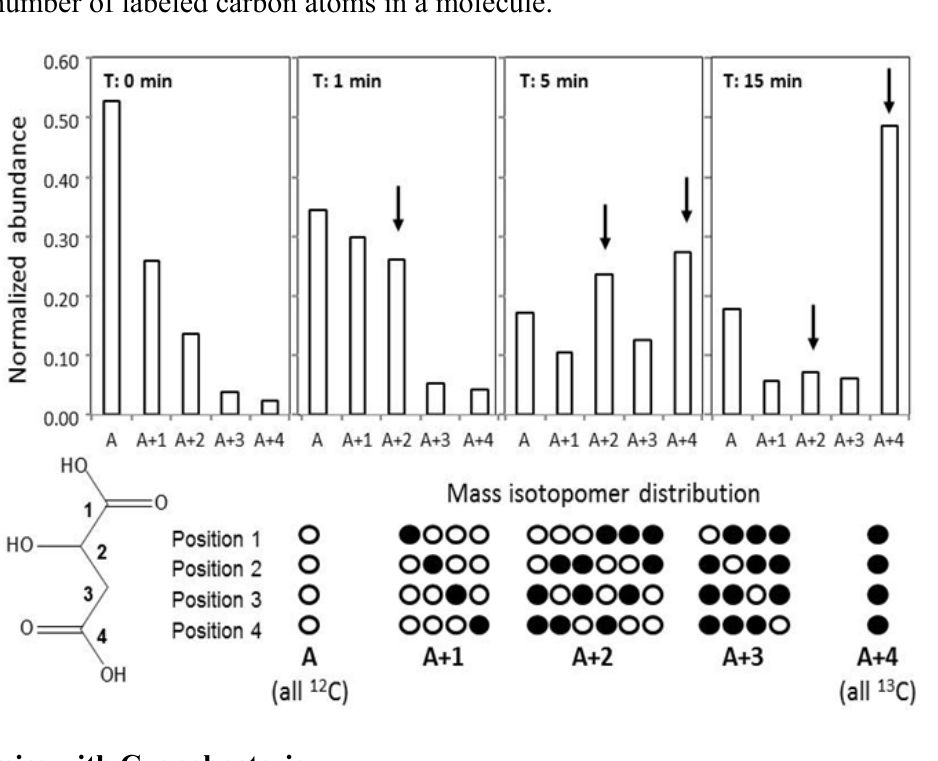
Figure 4. Mass isotopomer distributions of malate from a 13 C-pulse experiment of Synechocystis. 6803 wild type pre-acclimated to 0.035% CO